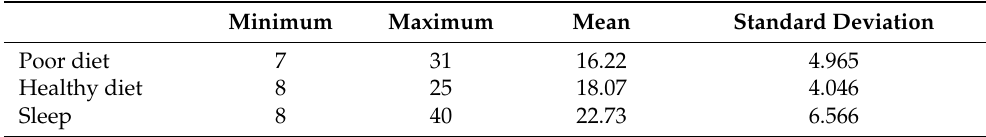
Table 3. Descriptive Statistics of Continuous Variables.